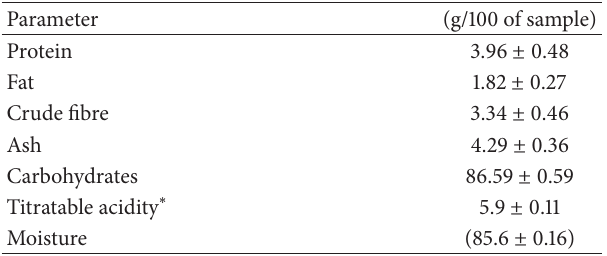
Table 1: Centesimal specification of nutrients (dry weight) and titratable acidity of C. uvifera